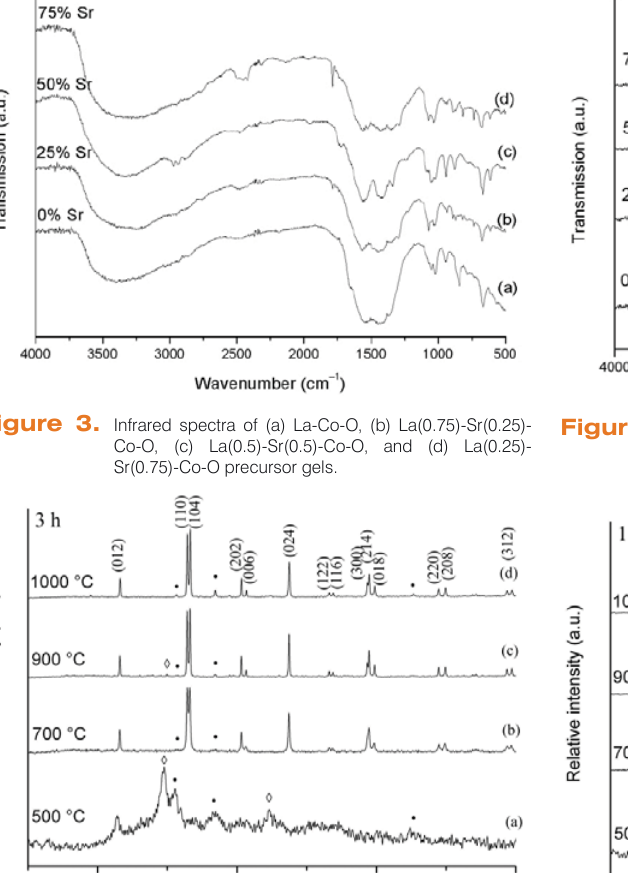
ceramics synthesized Figure 6. X-ray diffraction patterns of LaCoO 3 using the sol-gel method at different temperatures: phase are marked. 3